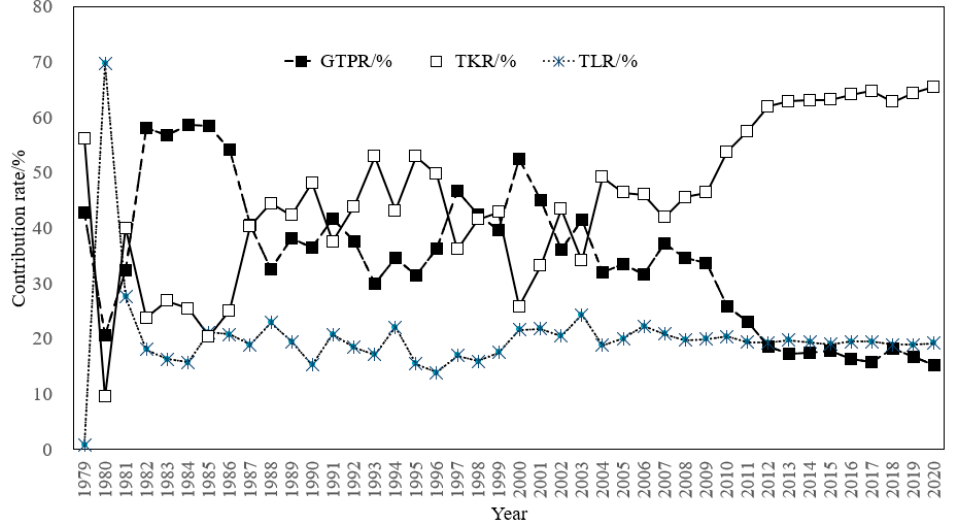
Figure 6. The contribution rates of rice input factors from 1979 to 2020.